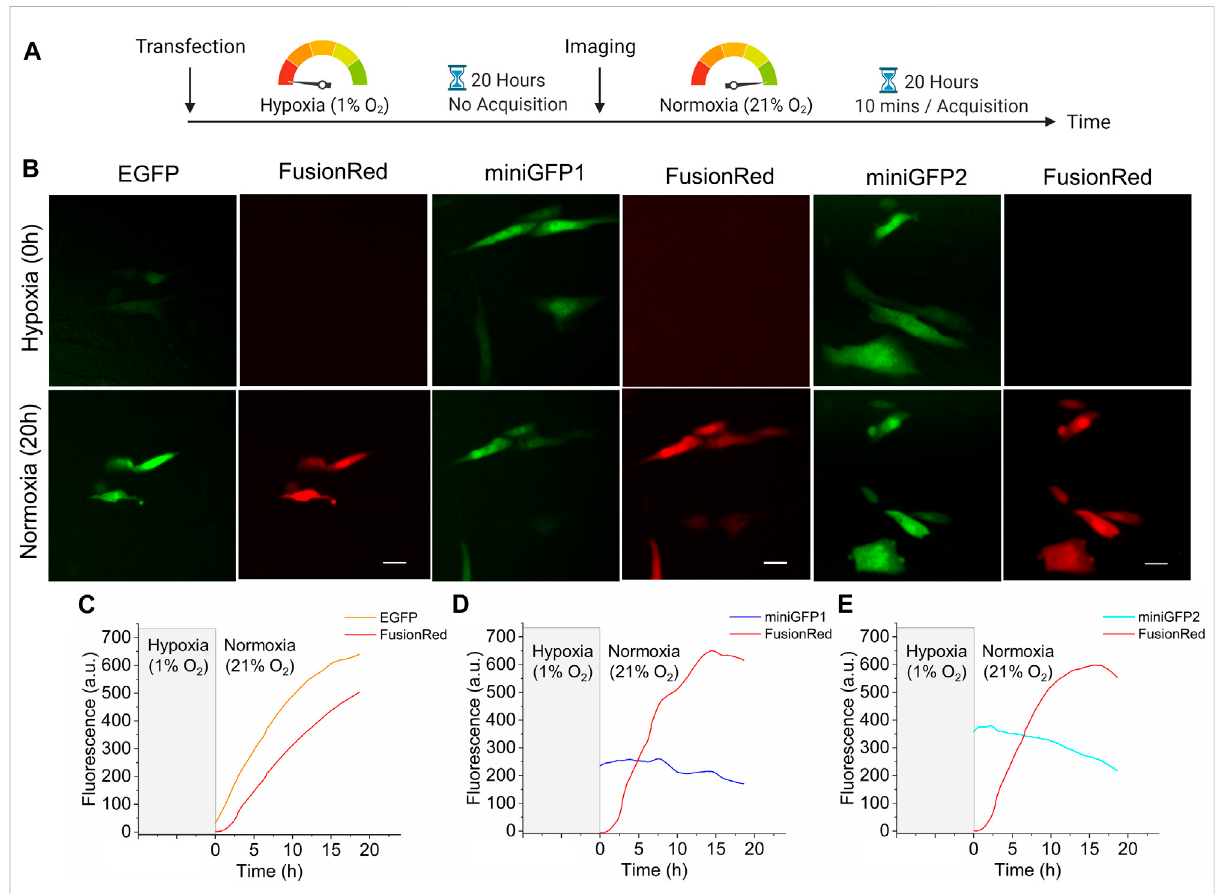
FIGURE 5 Characterization of miniGFPs under hypoxic conditions. (A) Experimental work fl ow of hypoxia experiments. (B) Fluorescence images of CHO cells expressing EGFP, miniGFP1 and miniGFP2 under hypoxia (upper row) and normoxia (lower row) conditions, respectively (for hypoxia images, cells after transfection were incubated under 1% oxygen, 10% carbon dioxide and 89% nitrogen condition for 20 h, for normoxia images, cells were incubated 20 h under 21% O2 atmosphere after hypoxia incubation). Scale bar, 20 µm. (C – E) The fl uorescence changes of CHO cells co- expressing (C) EGFP, (D) miniGFP1, and (E) miniGFP2 with FusionRed under normoxia condition after 20 h of hypoxic incubation. ( n = 10, 10, and 10 cells from 3, 2, 3 independent transfections for EGFP, miniGFP1, and miniGFP2,